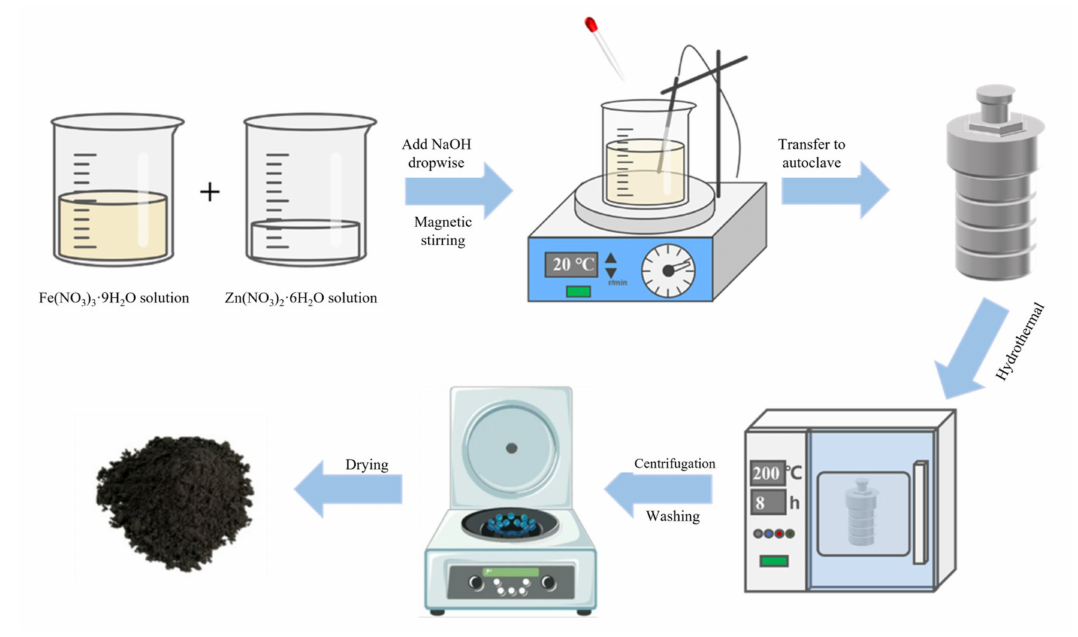
Figure 3. A schematic representation of the general steps used in the hydrothermal synthesis of ZnFe 2 O 4 .